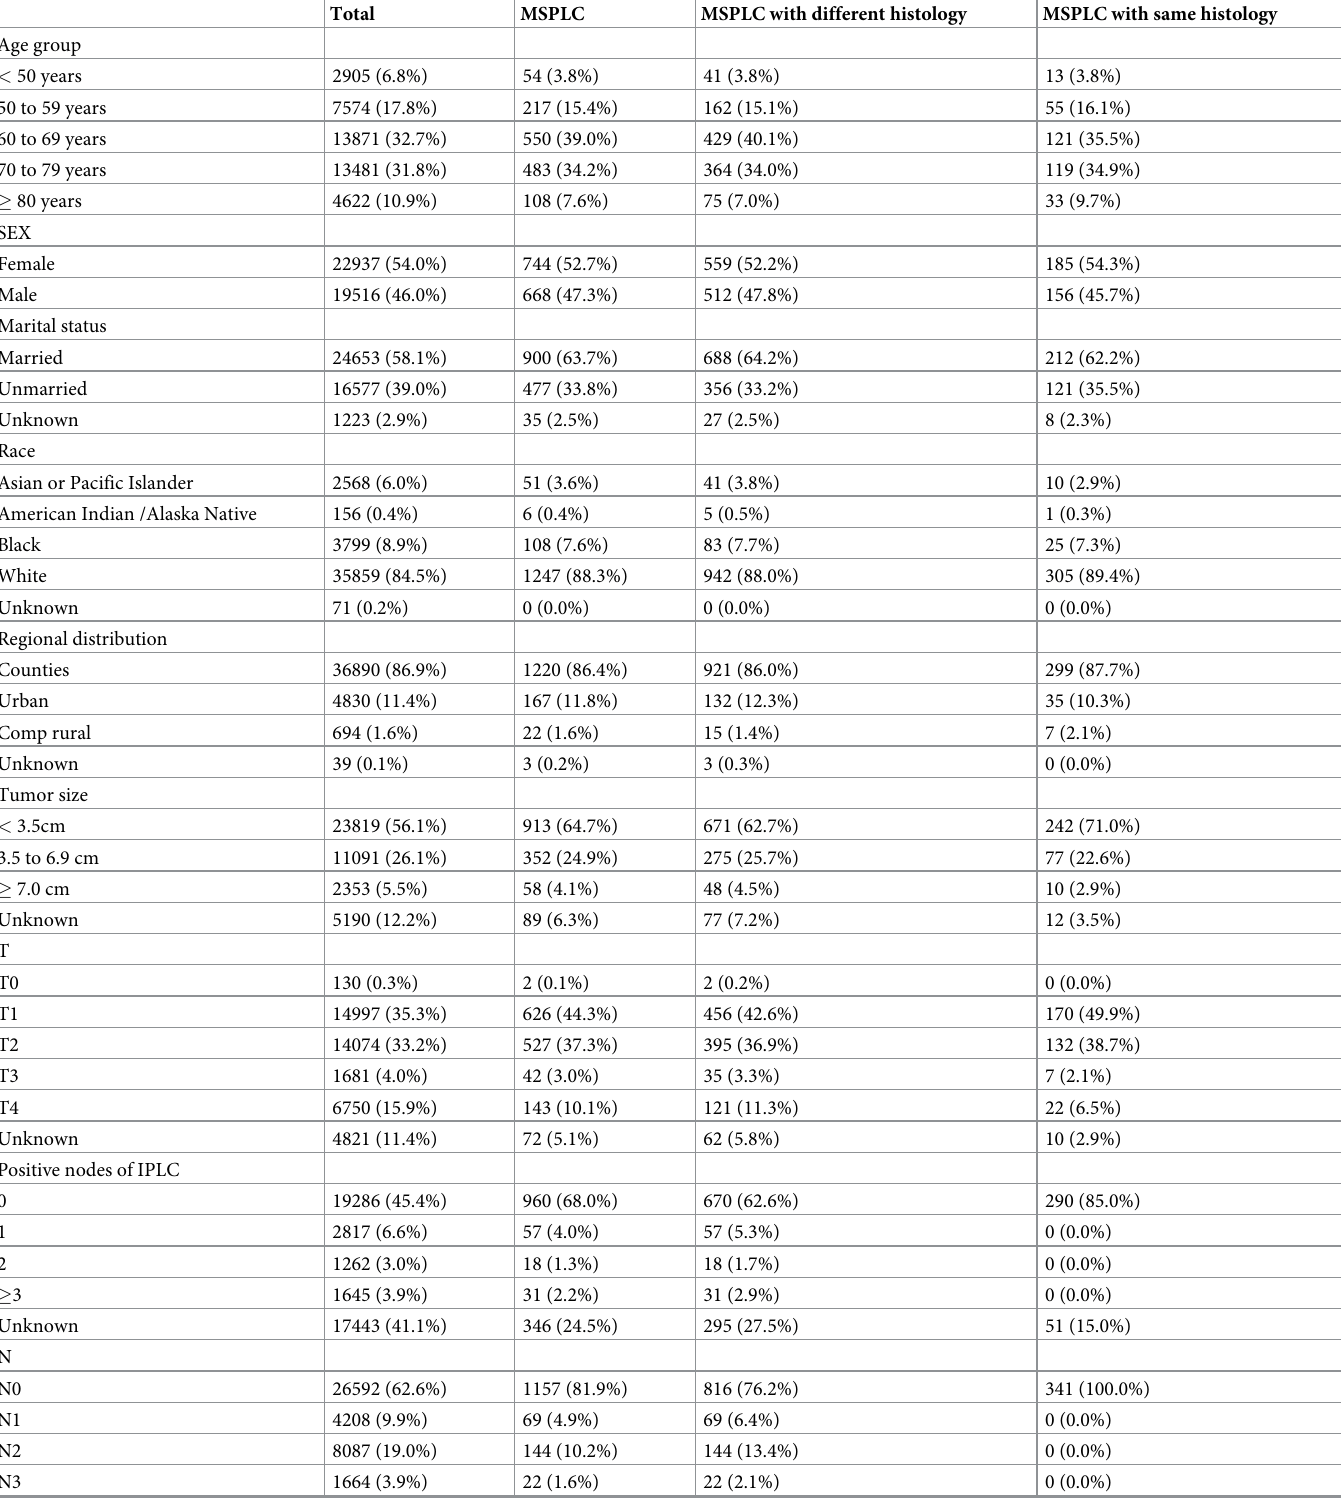
Table 1. Patient characteristics of the study population in